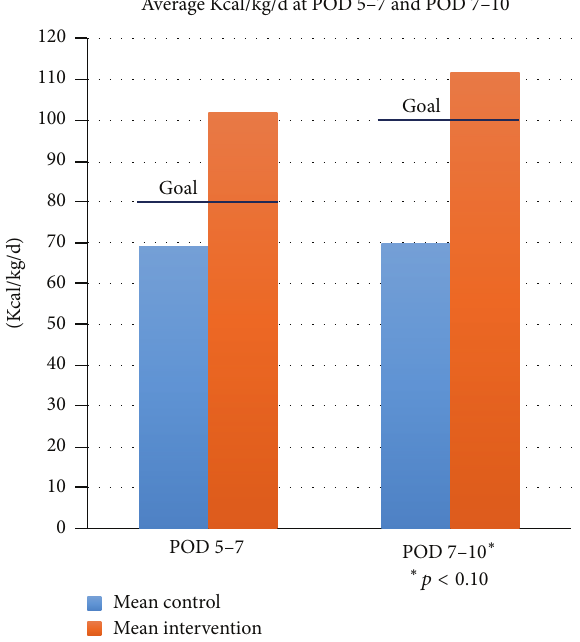
Figure 2: Mean caloric consumption on postoperative days 5–7 and 7–10. Goal caloric intake on POD 5–7 = 80 Kcal/kg/d; goal caloric intake on POD 7–10 =